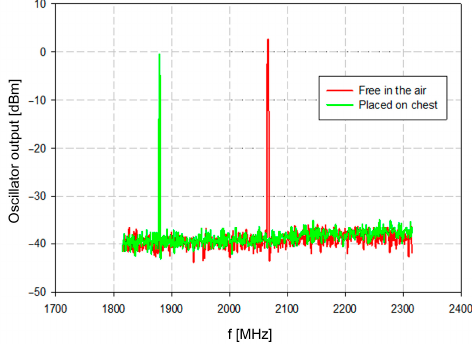
Figure 8. Oscillator test with two different operating conditions.